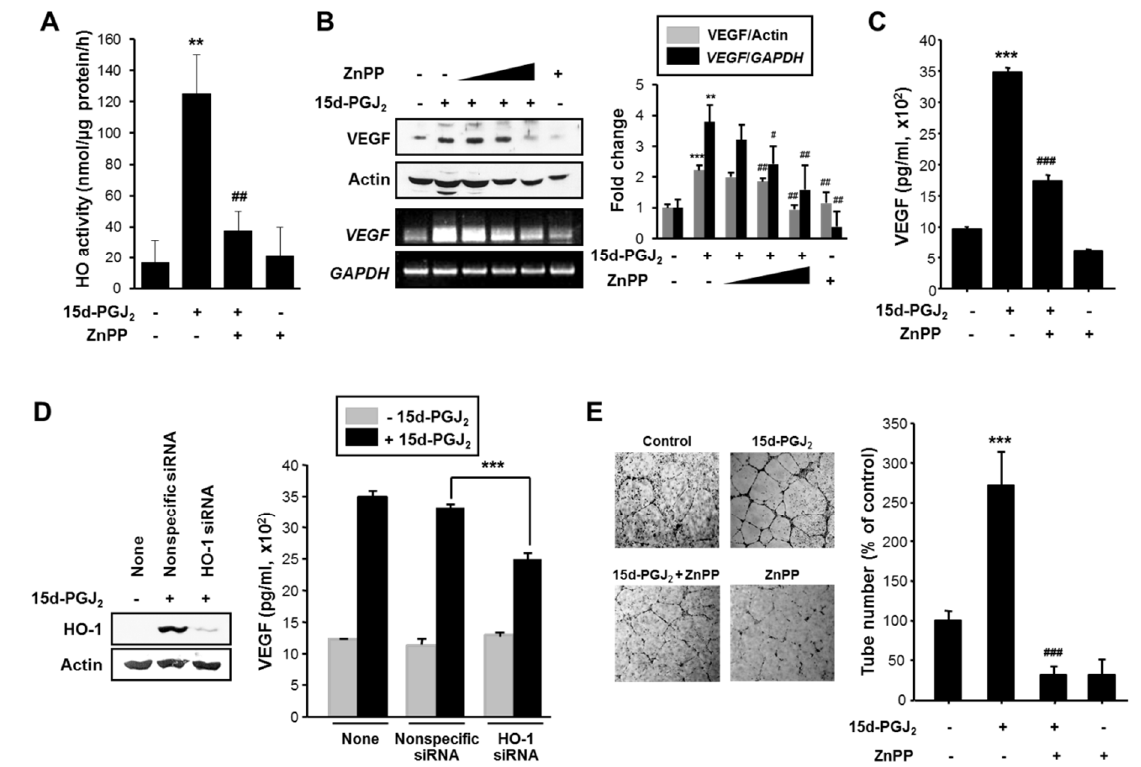
Figure 6. 15d-PGJ 2 induces angiogenesis through upregulation of HO-1 mediated by NRF2 activation. ( A ) 15d-PGJ 2 -induced HO activity was determined in MCF-7 cells treated with zinc protoporphyrin IX (ZnPP) (10 µ M), an HO-1 inhibitor, for 24 h. Data are means ± SD. ** p < 0.01, significantly different compared to vehicle control; ## p < 0.01, significantly different from 15d-PGJ 2 -treated cells. ( B ) Treatment with ZnPP (1 5, and 20 µ M) abrogated the 15d-PGJ 2 -induced expression of VEGF protein and mRNA. Data are means ± SD. ** p < 0.01 and *** p < 0.001, significantly different compared to vehicle control; # p < 0.05 and ## p < 0.01, significantly different from 15d-PGJ 2 -treated cells. ( C ) The enzyme immunoassay was conducted to measure the VEGF production in MCF-7 cells exposed to 30 µ M 15d-PGJ 2 in the presence or absence of ZnPP. Data are means ± SD. *** p < 0.001, significantly different compared to vehicle control; ### p < 0.001, significantly different from 15d-PGJ 2 -treated cells. ( D ) MCF-7 cells were transfected with HO-1 siRNA for 24 h and treated with 15d-PGJ 2 for an additional 24 h. Western blotting was conducted to confirm HO-1 knockdown. The production of VEGF was determined by ELISA. Data are means ± SD. *** p < 0.001, significantly different compared to nonspecific siRNA-transfected cells. ( E ) HUVECs were treated with conditioned media containing 10% FBS. After 16 h incubation with 15d-PGJ 2 (0 or 30 µM) in the presence or absence of 10 µM ZnPP, microphotographs were taken (’40). Representative endothelial tubes were shown. Tube formation (%) was quantified by the number of three-way branching point. Values are means ± SD of three independent experiments. *** p < 0.001, significantly different compared to vehicle control; ### p < 0.001, significantly different from 15d-PGJ 2 -treated cells.